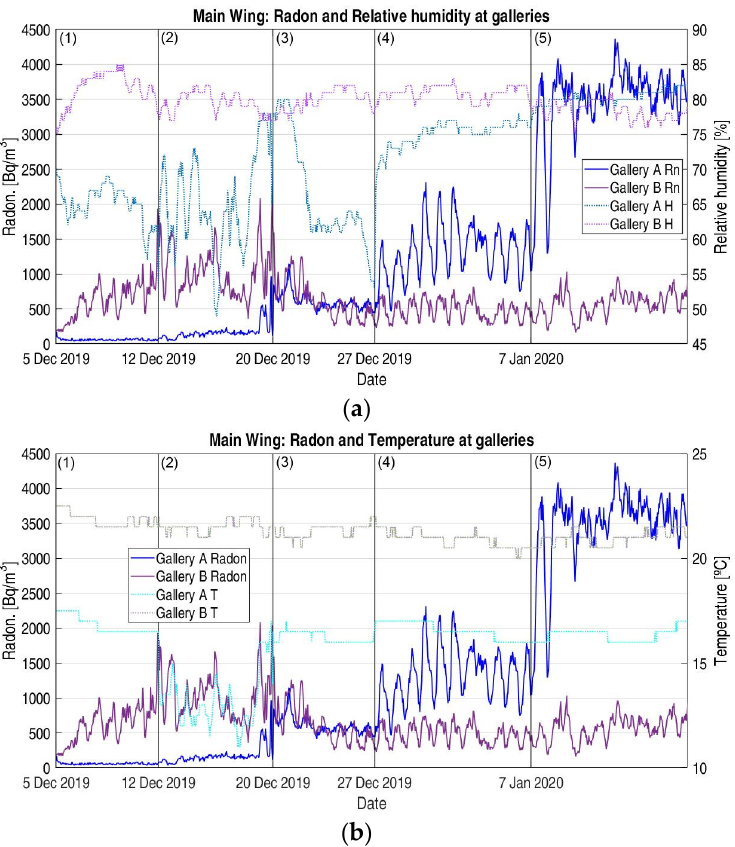
Figure 10. ( a ) Radon and relative humidity in Galleries A and B. ( b ) Radon and temperature in Galleries A and B. (1) Pressurization test, (2) forced cross-ventilation test, (3) depressurization test, (4) single-sided natural ventilation, (5) natural state (reference state).